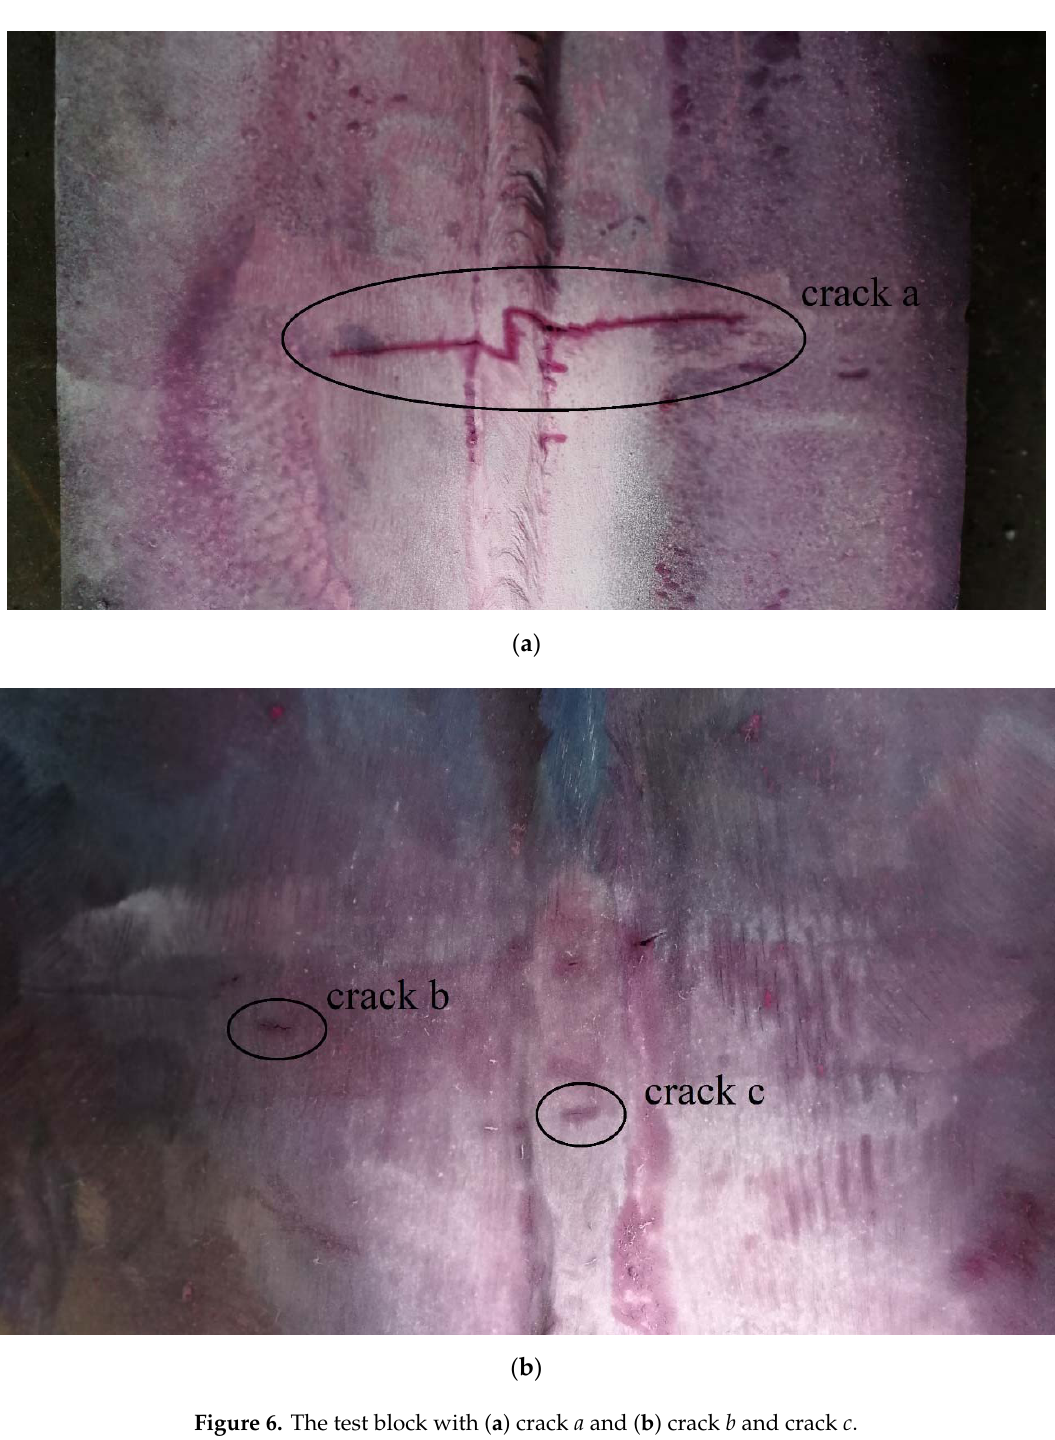
Figure 6. The test block with ( a ) crack a and ( b ) crack b and crack c.